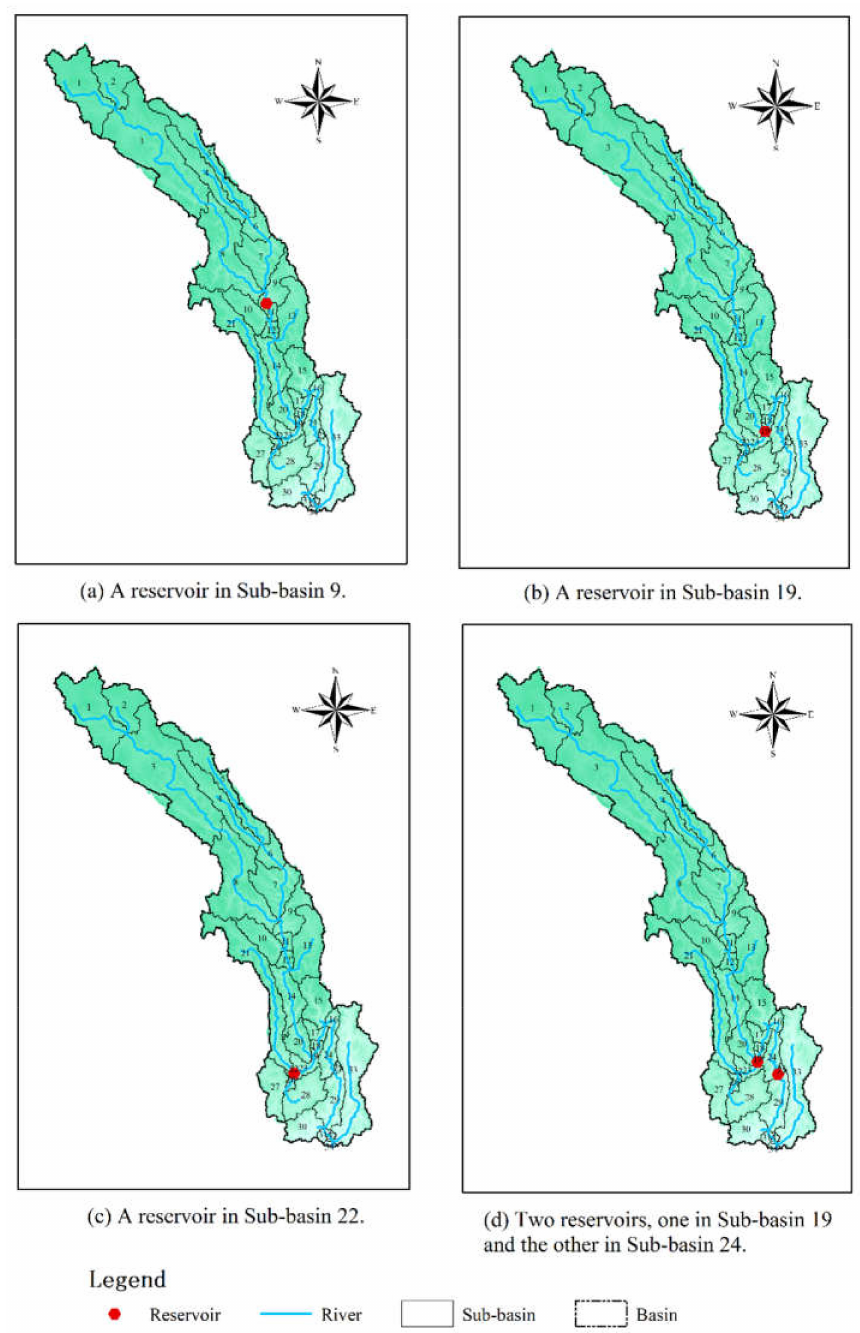
Figure 3. Distribution of reservoirs in different